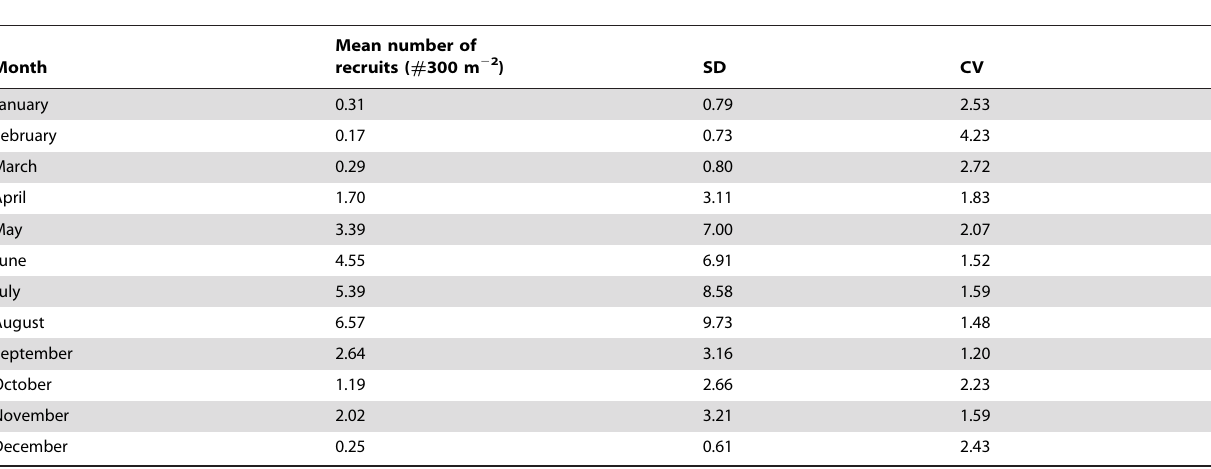
Table 1. Monthly variability in recruitment of Stegastes partitus to reefs in the upper Florida Keys.